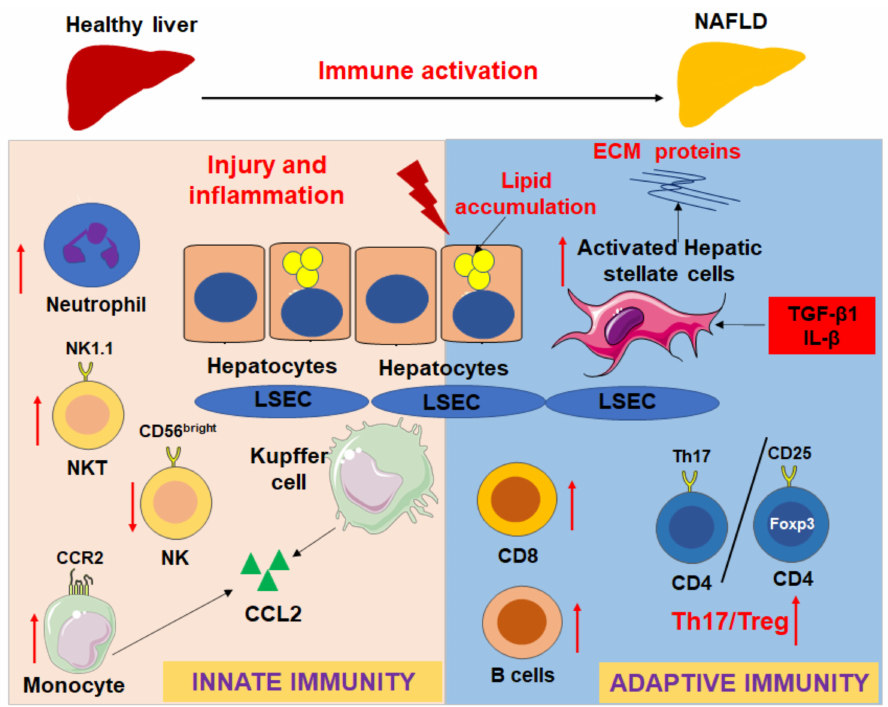
Figure 2. Innate and adaptive immune responses in the progression of NAFLD and liver fibrosis. Red arrows show that the immune cells will be recruited into the fatty liver during NAFLD development, such as CCR2 + monocytes/macrophages and neutrophils; the ratio of Th17/Tregs increases, NKT cell, CD8 T cells, and B cells are activated and increased in different extend according to different models; however, CD56 bright NK cells are decreased. The immune activation and hepatocyte injury will impact the activation of hepatic stellate cells (HSCs) to express extracellular matrix (ECM) proteins via upregulation of profibrotic and proinflammatory cytokines, such as TGF- β 1 and IL- β